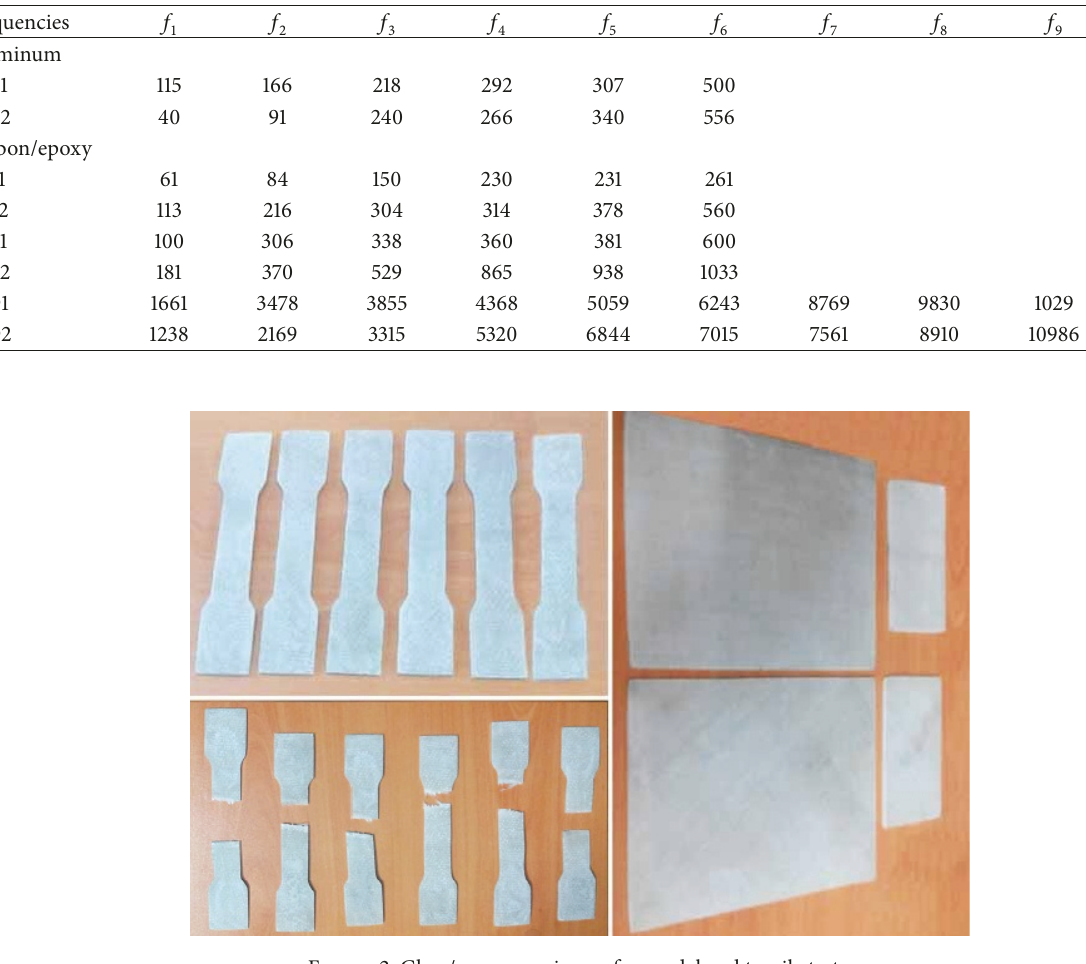
Figure 2: Glass/epoxy specimens for modal and tensile